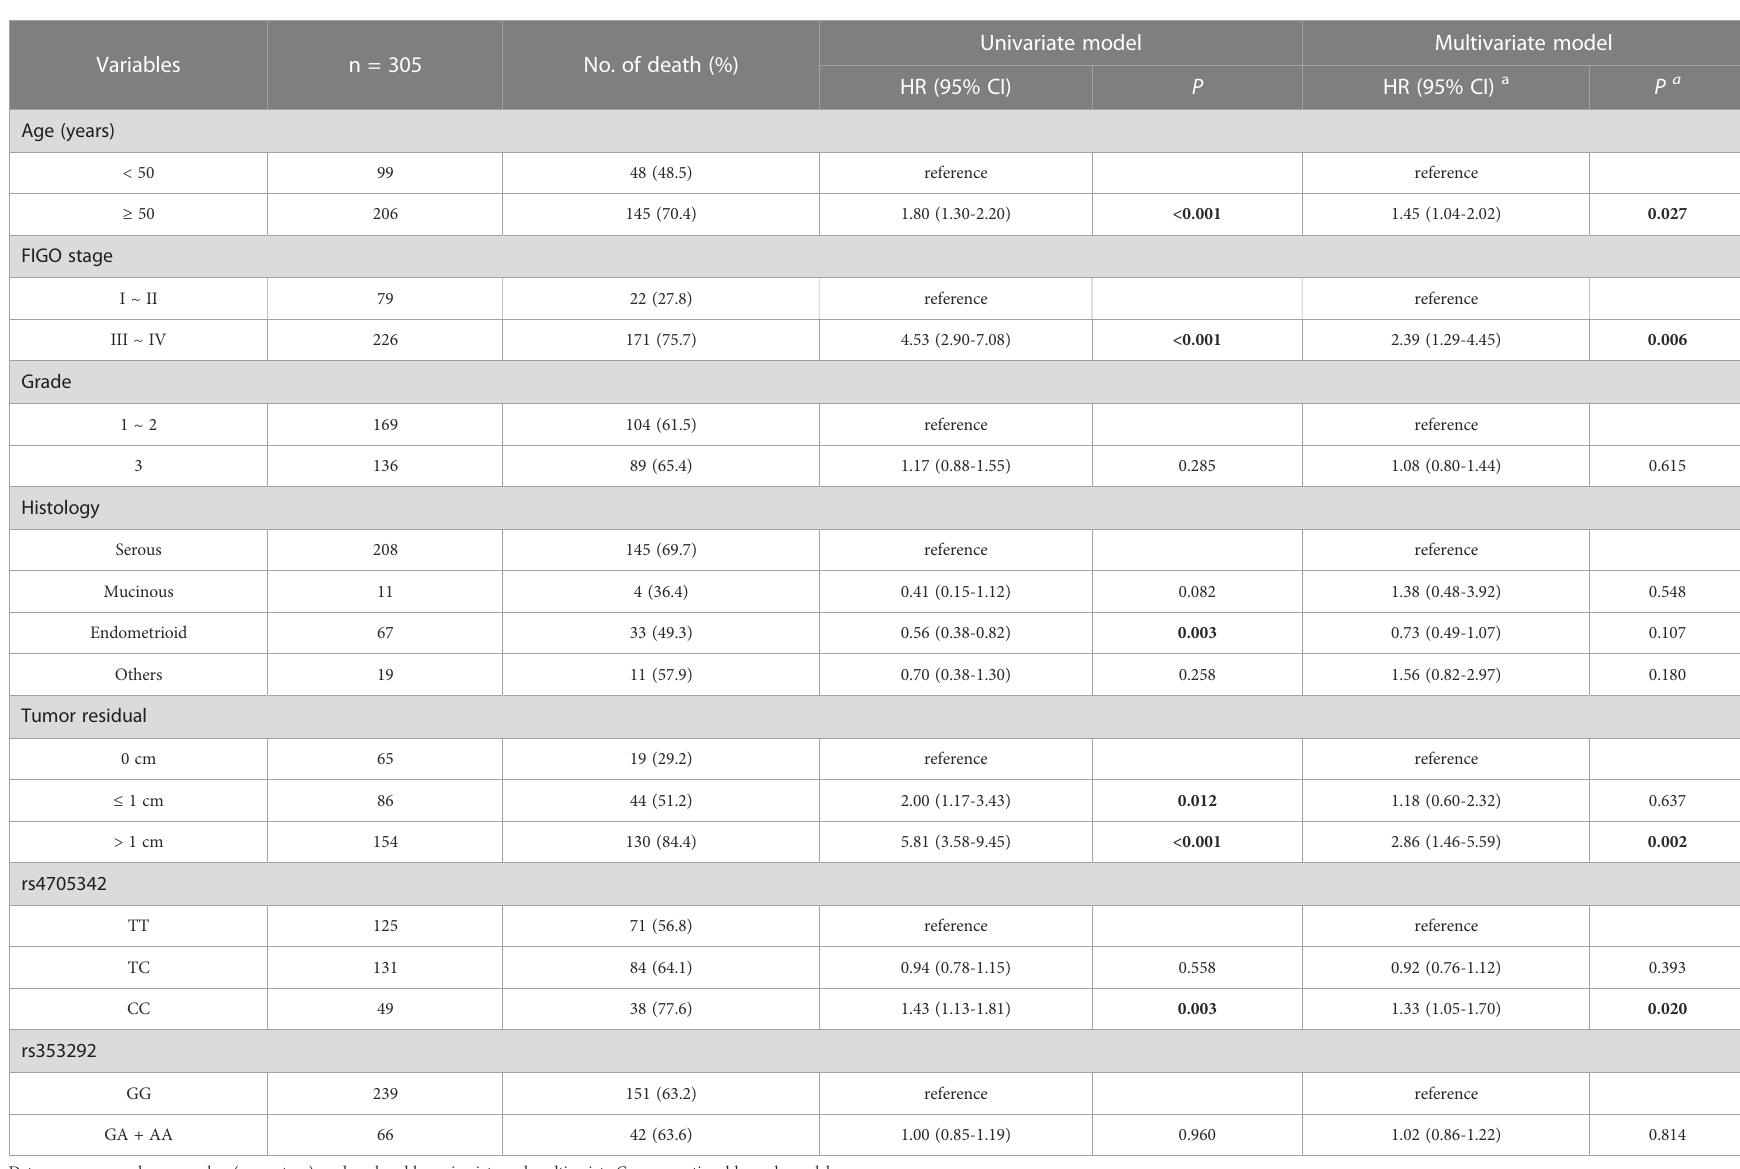
TABLE 4 Association of variables with the 5-year overall survival of epithelial ovarian cancer